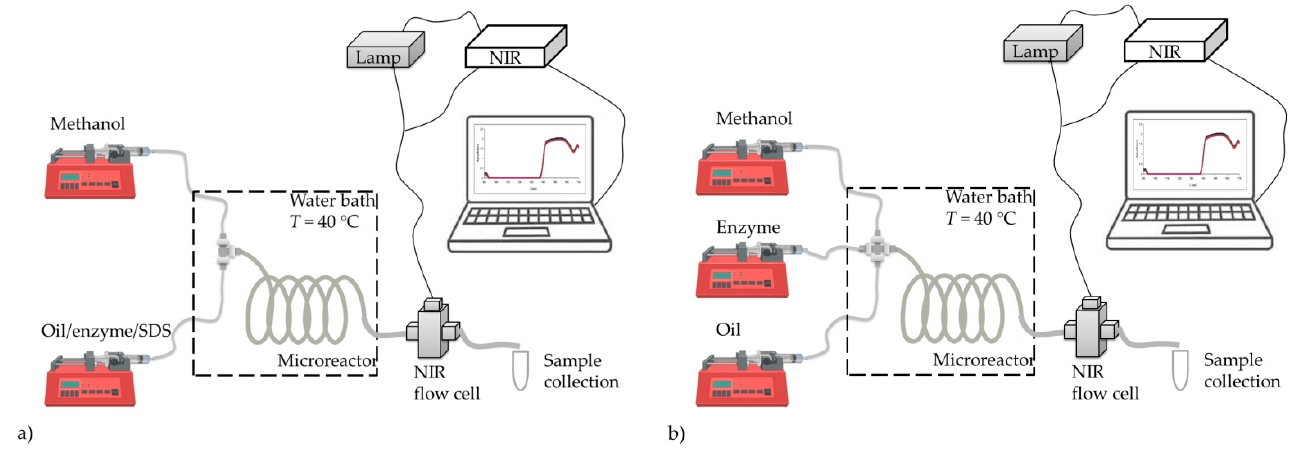
Figure 2. Experimental set-up used for biodiesel production in a microreactor by ( a ) 2-inlet strategy and ( b ) 3-inlet strategy.